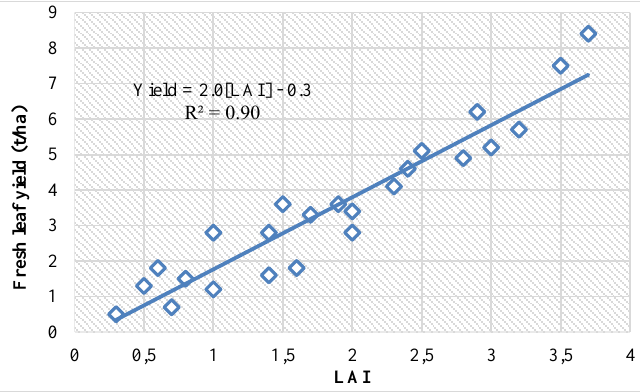
Figure 10b. Regression analysis between fresh rape leaf yield and LAI